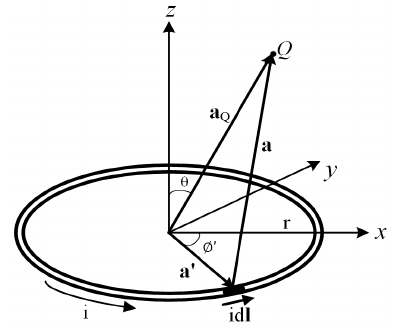
Figure 1. The symmetry axis magnetic field due to a circular current loop [17].